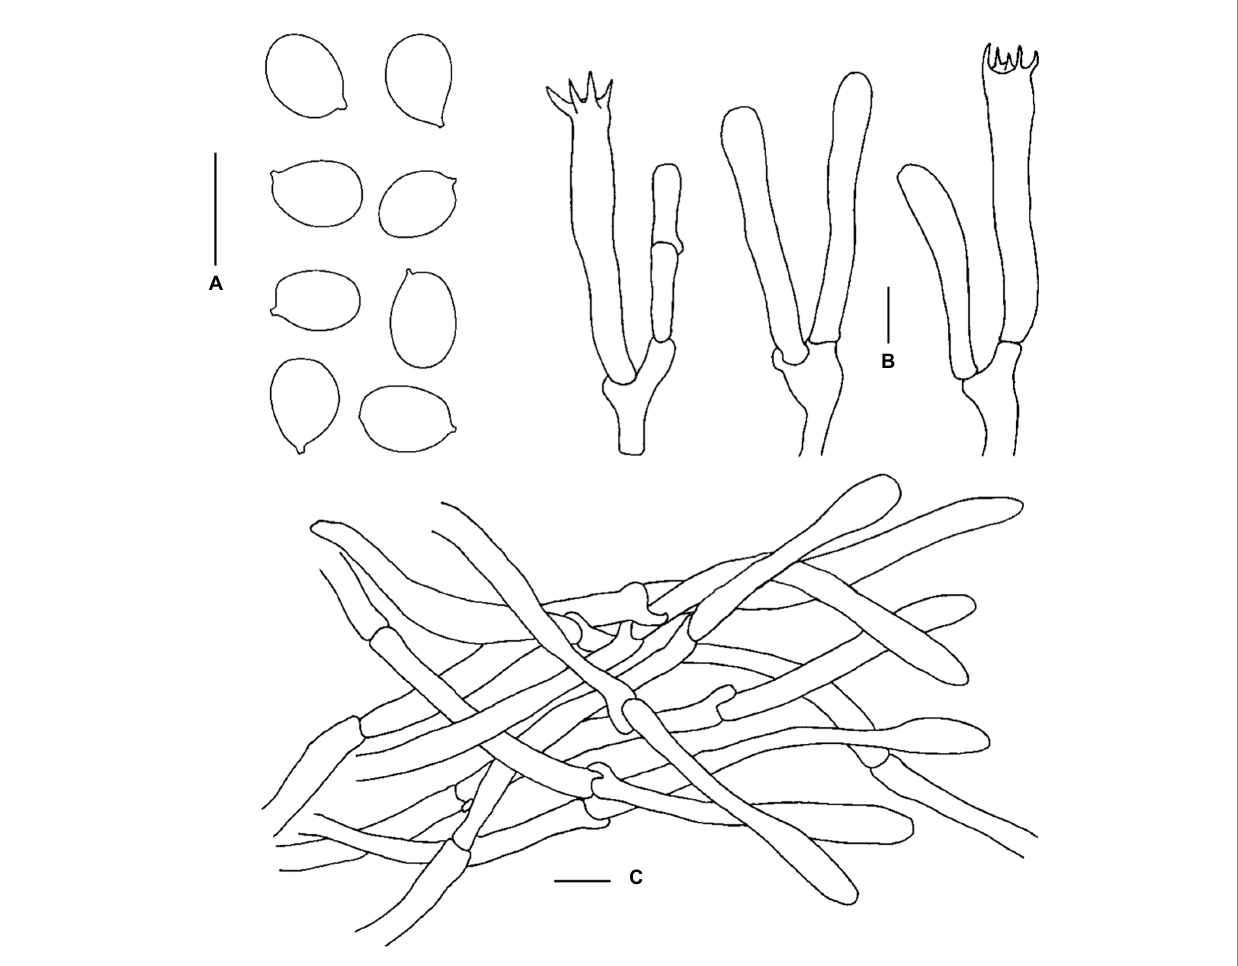
FIGURE 6 Microscopic features of Cantharellus laevigatus (FHMU6951, holotype). (A) Basidiospores. (B) Basidia. (C) Pileipellis. Scale bars = 10 μ m. Drawings by Y. Z.